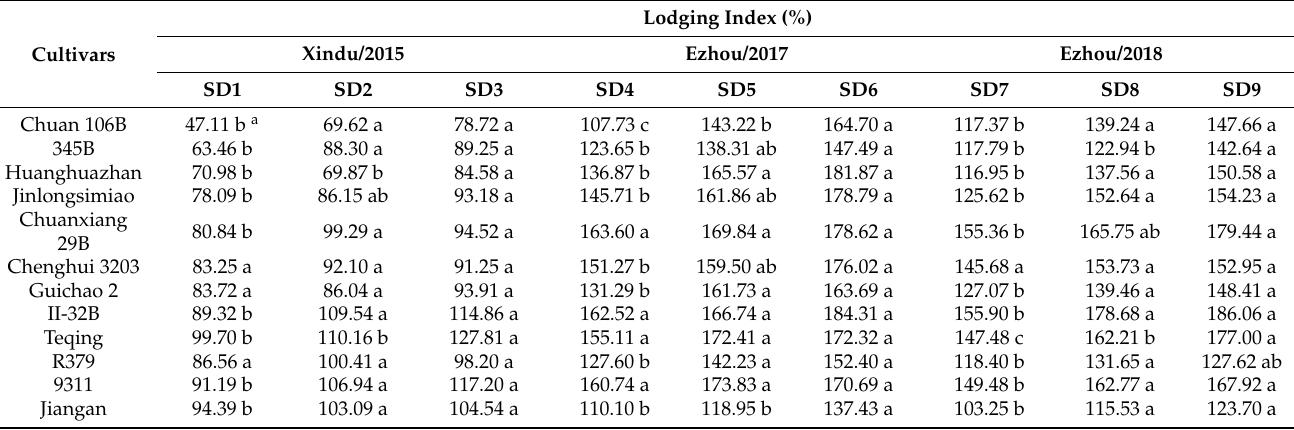
Table 2. The lodging index of twelve indica rice cultivars on all the sowing dates across two locations and three years.